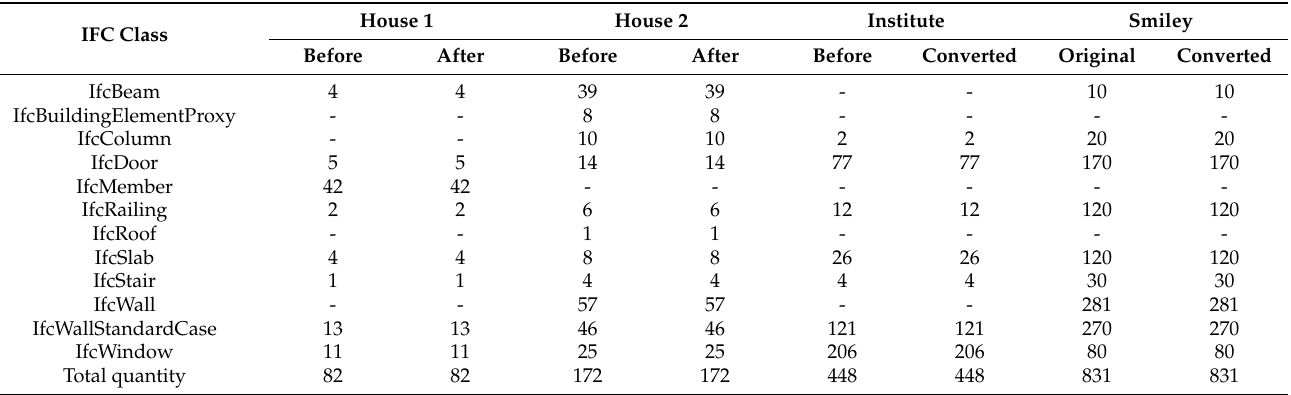
Table 7. Quantity of building components before and after conversion.